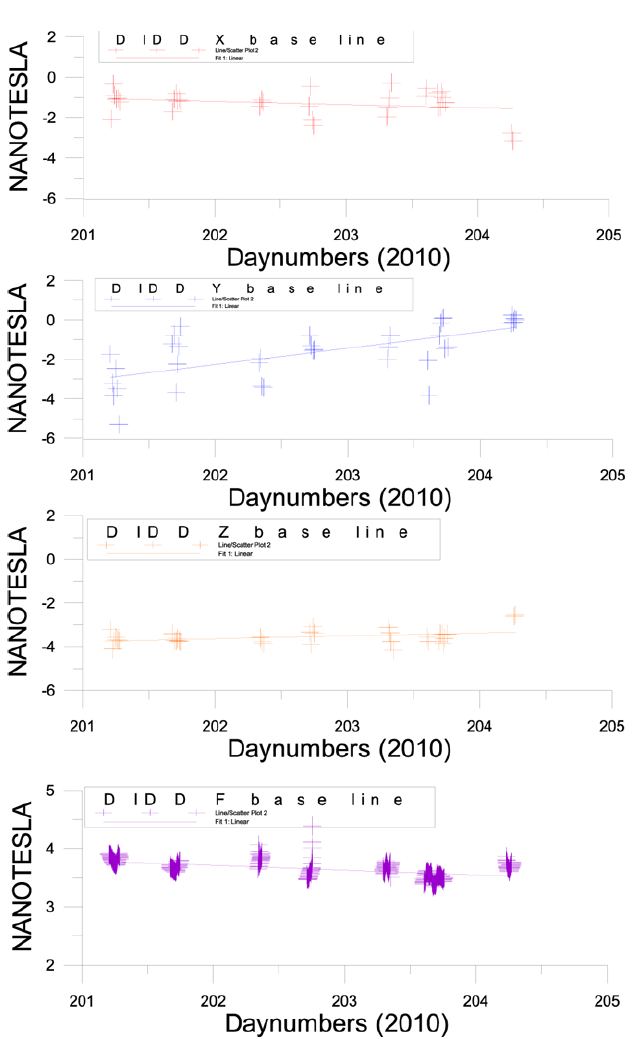
Figure 10. The adopted baseline of DIDD near the KRBP